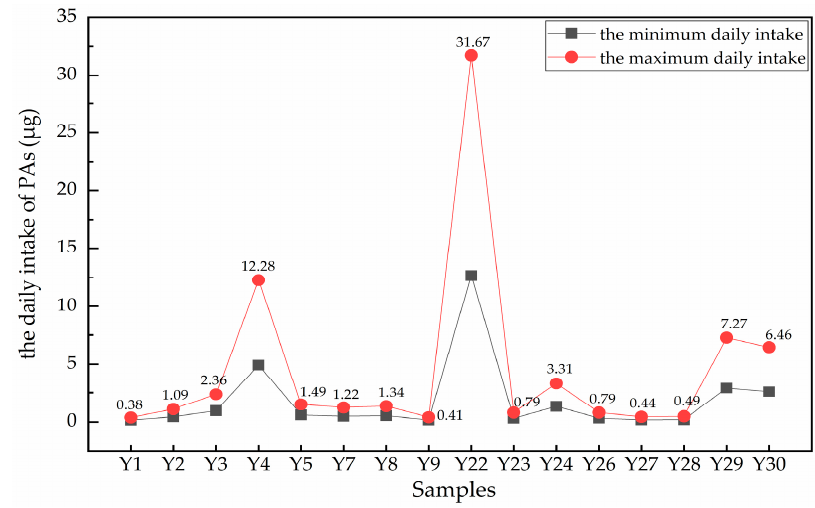
Figure 7. The maximum and the minimum daily intakes of A. capillaris . Only the 16 samples that displayed maximum daily intakes exceeding the baseline value (0.35 μ g/day for a 50 kg person) are shown and their calculated values are marked on the chart.